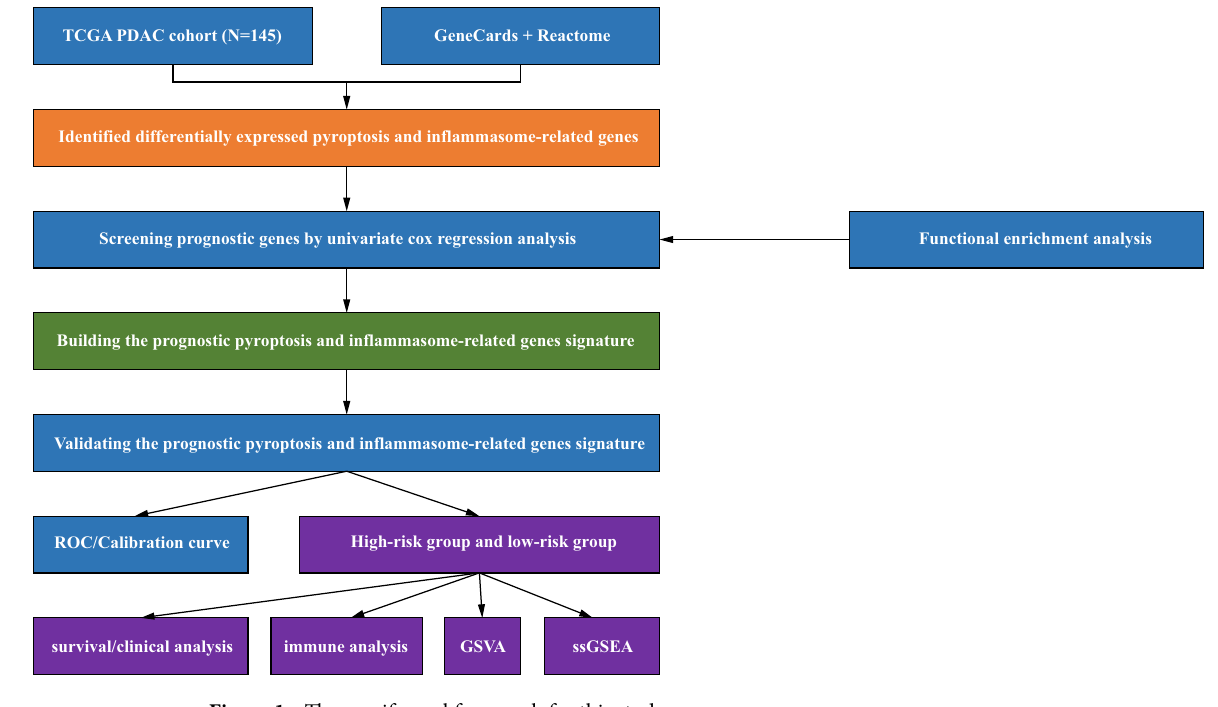
Figure 1. The specifc workfow graph for this